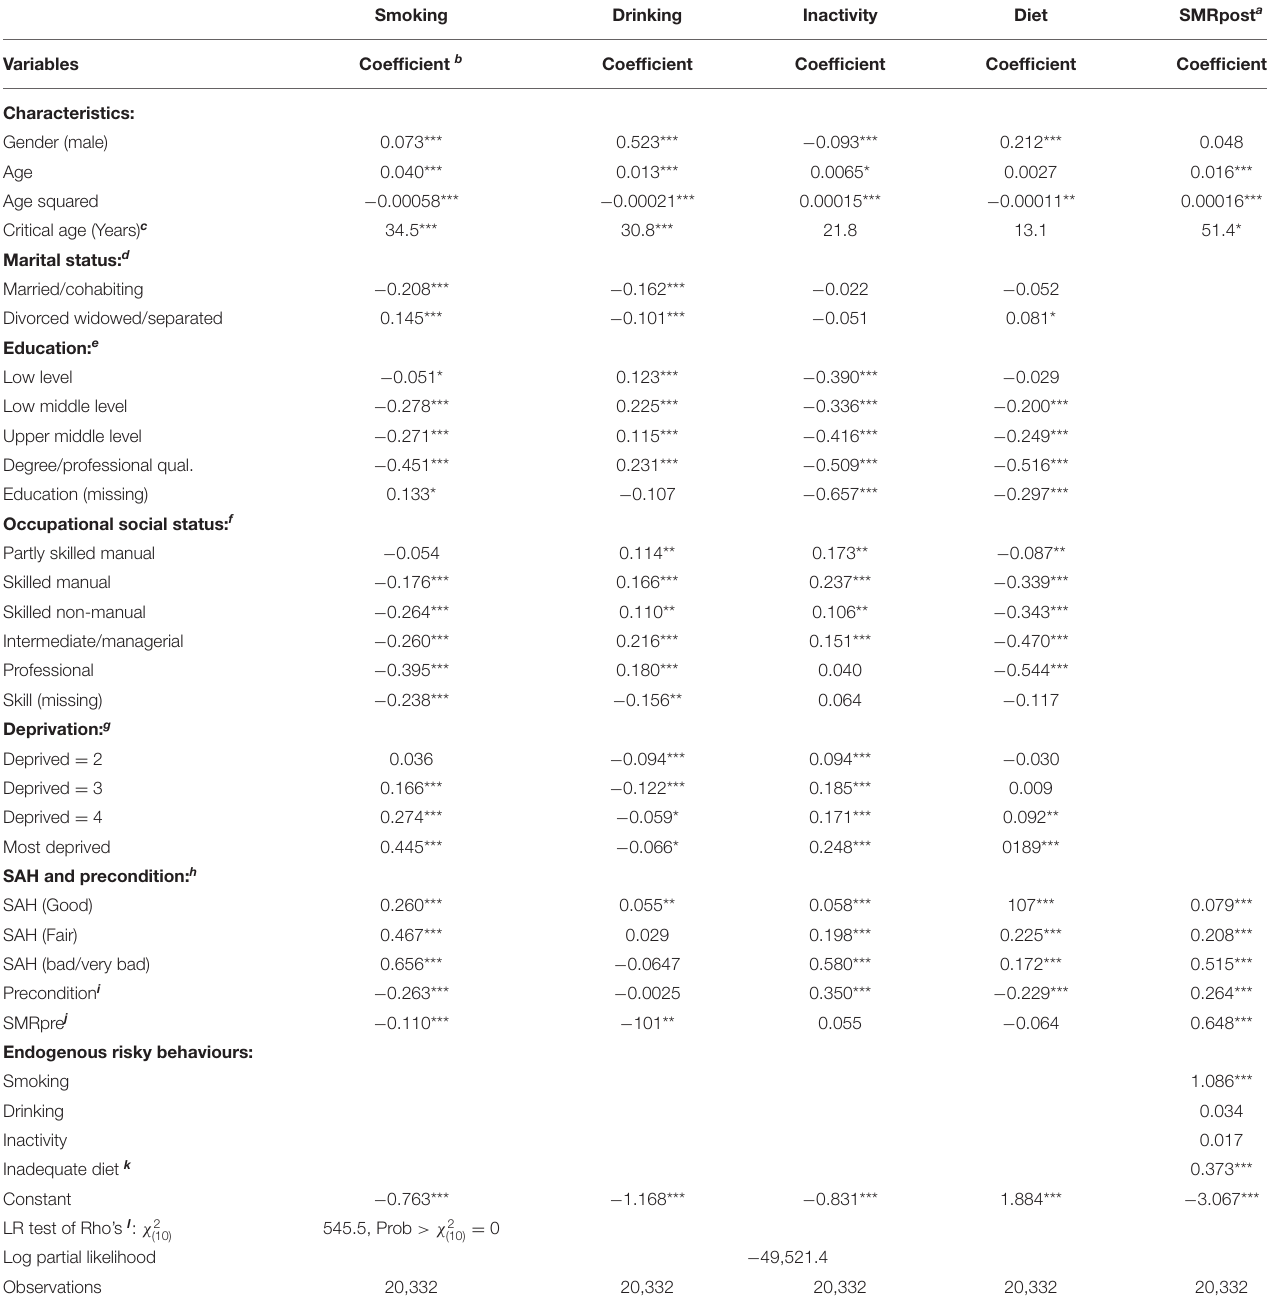
TABLE 2 | Recursive multivariate probit regression: Whole